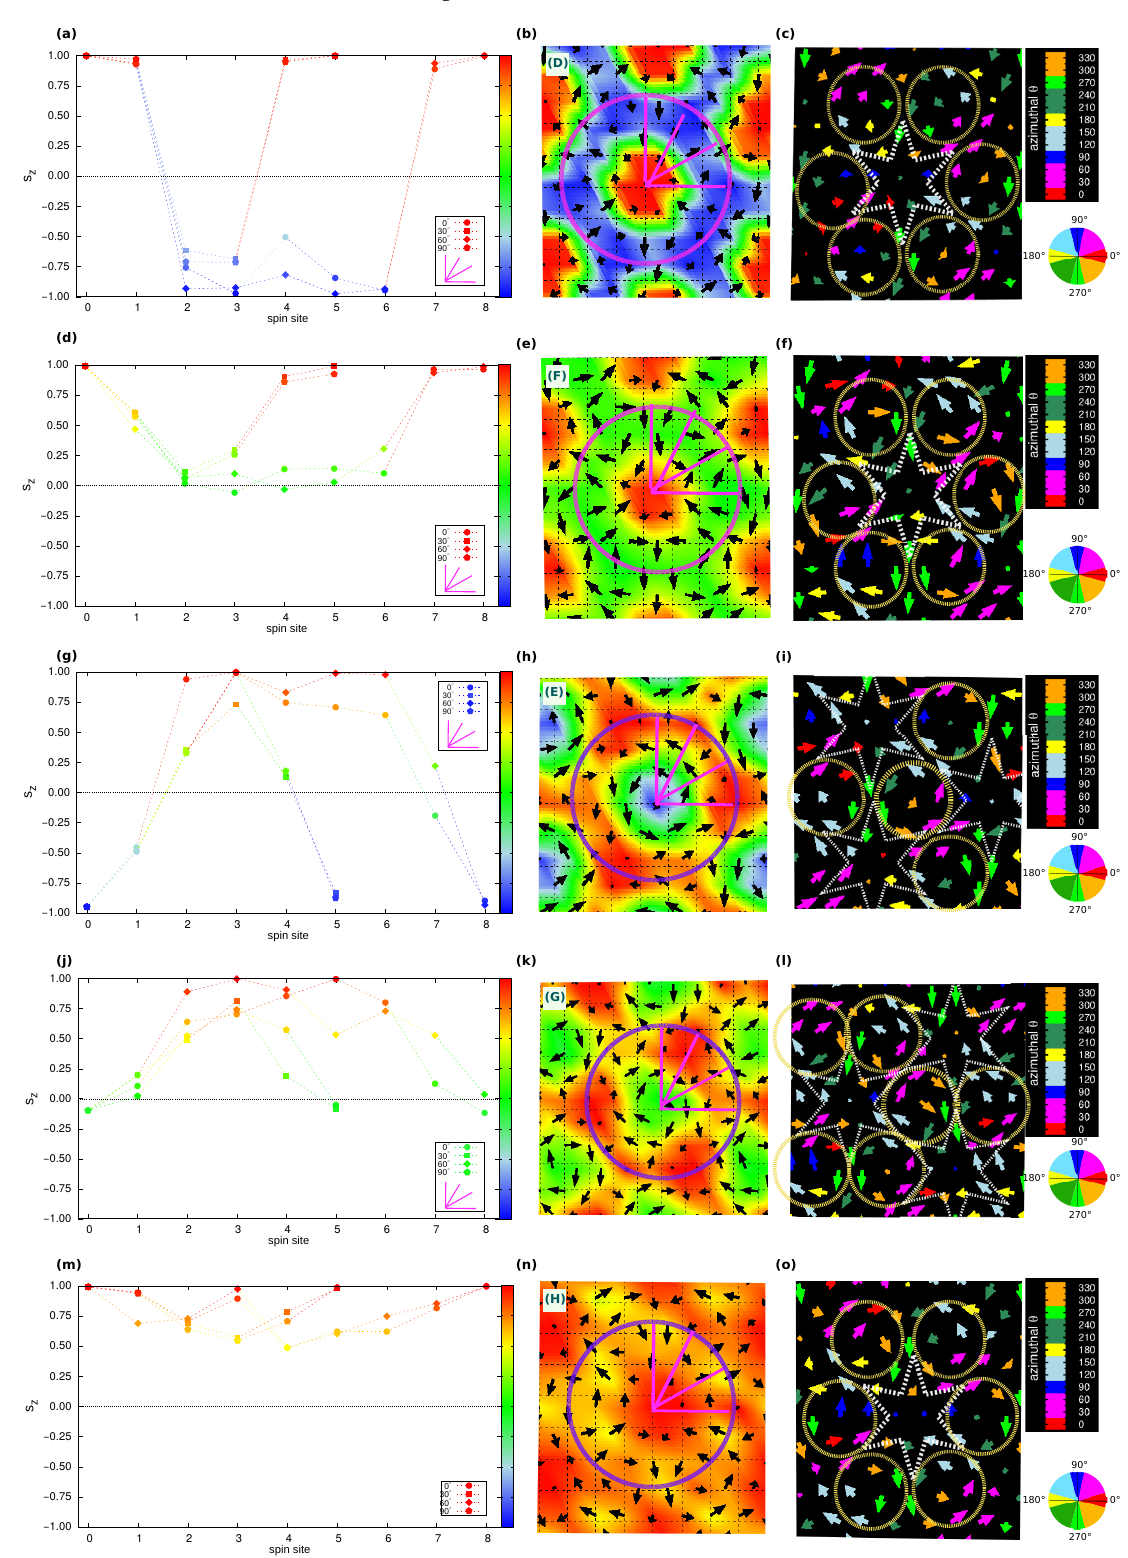
Figure 8. Profile of the out-of-plane component of spins ( s z ) and planar spin texture with associated azimuthal angle defined by the { s x , s y } components, as in Figure 7a–c, for the A2SK-type lattice of the D-phase ( a – c ), the A2M-lattice of the F-phase ( d – f ), the Bloch-type SK-lattice of the E-phase ( g – i ), the meron lattice of the G-phase ( j – l ), and the trivial triple- q state of the H-phase ( m – o